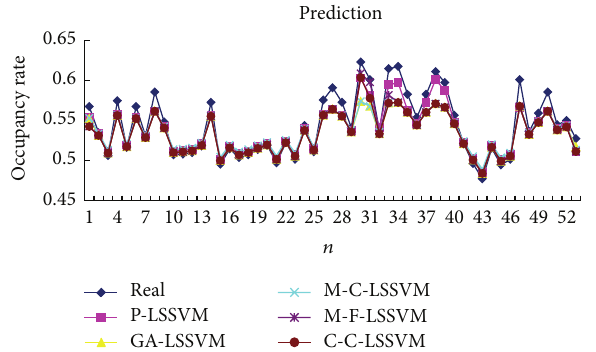
Figure7:FivemodelspredicteddiagramforFMbroadcastingband.